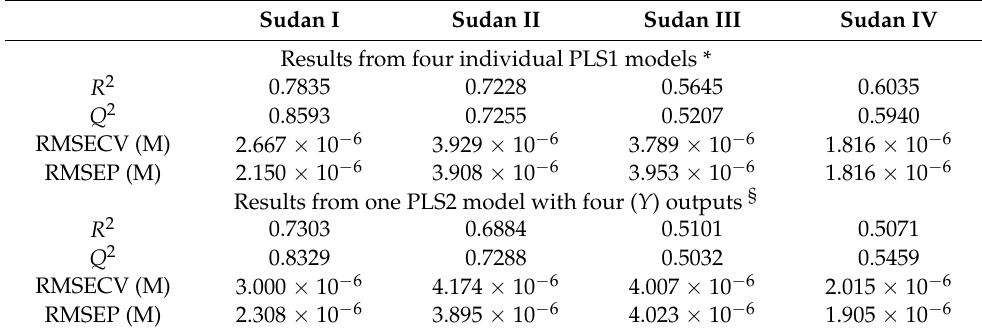
Figure 5. Results of PLS − R predictions vs. known concentrations of four dyes in a multiplex mixture sampled using SERS for: ( a ) Sudan I, ( b ) Sudan II, ( c ) Sudan III and ( d ) Sudan IV. In PLS − R modelling 1000 bootstrap resamples were used in each of the four PLS1 models and the plots show the average (as triangles) and the error bars the standard deviations from the 1000 test sets. Table 2. PLS − R results from the quadruplex mixtures.